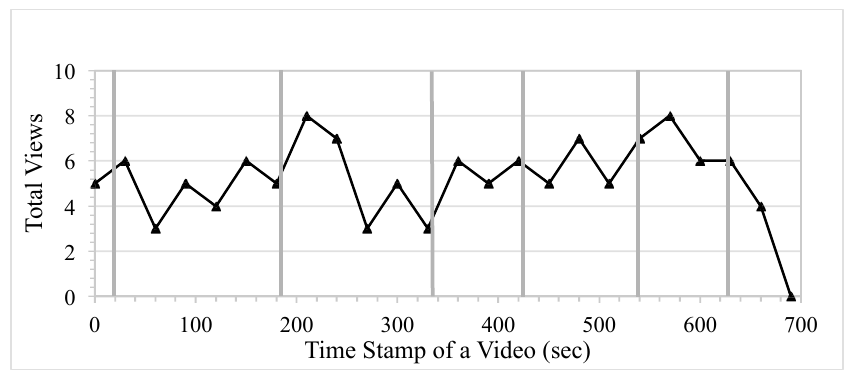
Fig. 4. Total Views vs. time plot for Lecture 15(Shear & Moment Diagrams). The grey vertical lines indicate when a slide